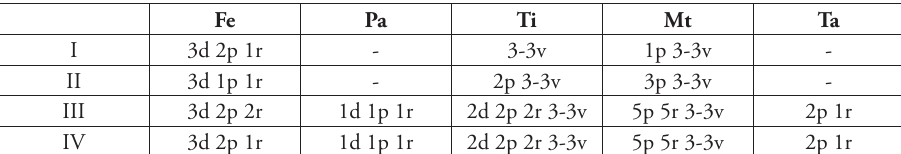
the radial grooves indistinct. Abdomen grayish, with blackish herringbone patterns. Palp as in Fig. 3: patellar apophysis long, about 2 times longer than tibia; tibia short, about 1/4 length of cymbium; cymbial furrow short, about 1/5 length of cymbium; ventral tibial apophysis subequal to the tibial length, without pointed tip; conductor broad and bifurcated; posterior tip of conductor bifurcated; anterior tip of conductor bifurcated, ventral part nearly spine-shaped, dorsal part lamellate; median apophysis indistinct; embolus beginning at 6:00 o’clock